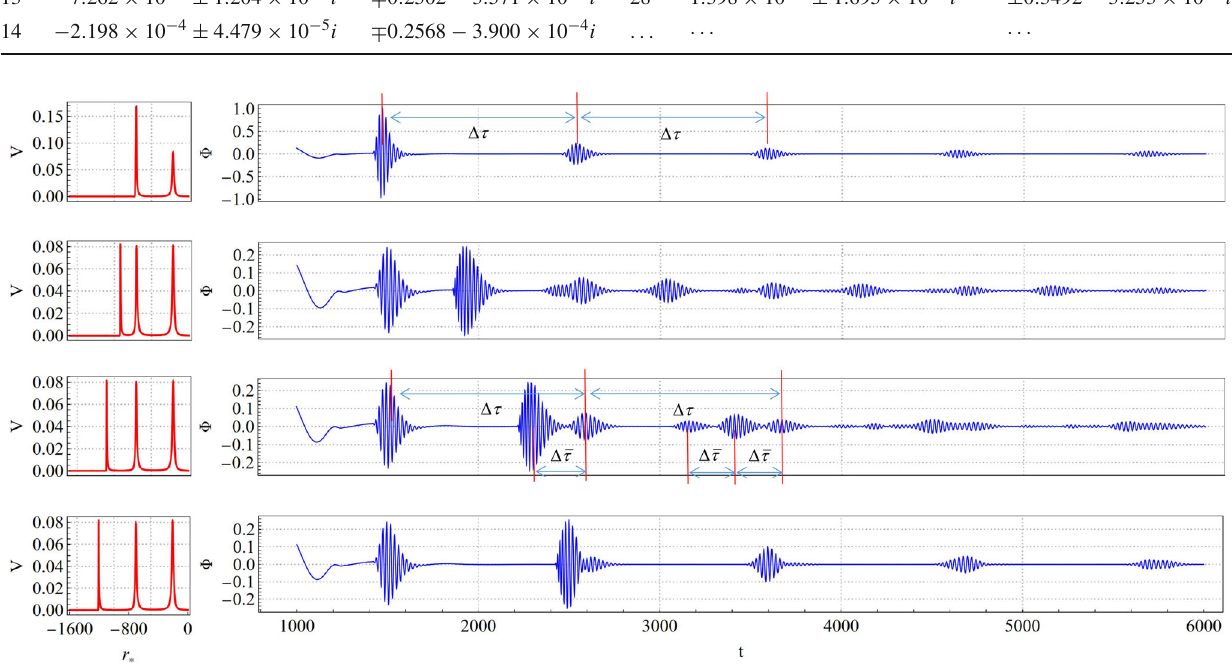
Fig. 3 The effective potential as a function of r ∗ and its correspond- ing time-domain profile. The parameters are M = 2 . 24587 , c 2 = 5 . 21202 , c 6 = − 3 . 80336 , c 10 = 3 . 23742 , c 14 = − 1 . 15436 for the 1st panel, M = 2 . 28227 , c 2 = 5 . 40395 , c 6 = − 4 . 63099 , c 10